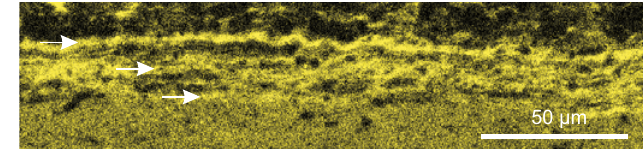
Fig. 7. A close-up of the microbial mat in Fig. 6B. The arrows point to individual carbon-rich